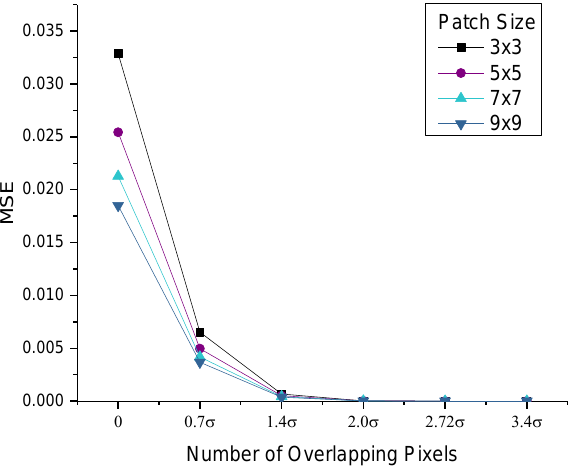
Figure 8. Error between the diffused images using two kinds of iterations (full-frame iteration and independent block-level iteration). The error quickly drops with the increase of overlapping